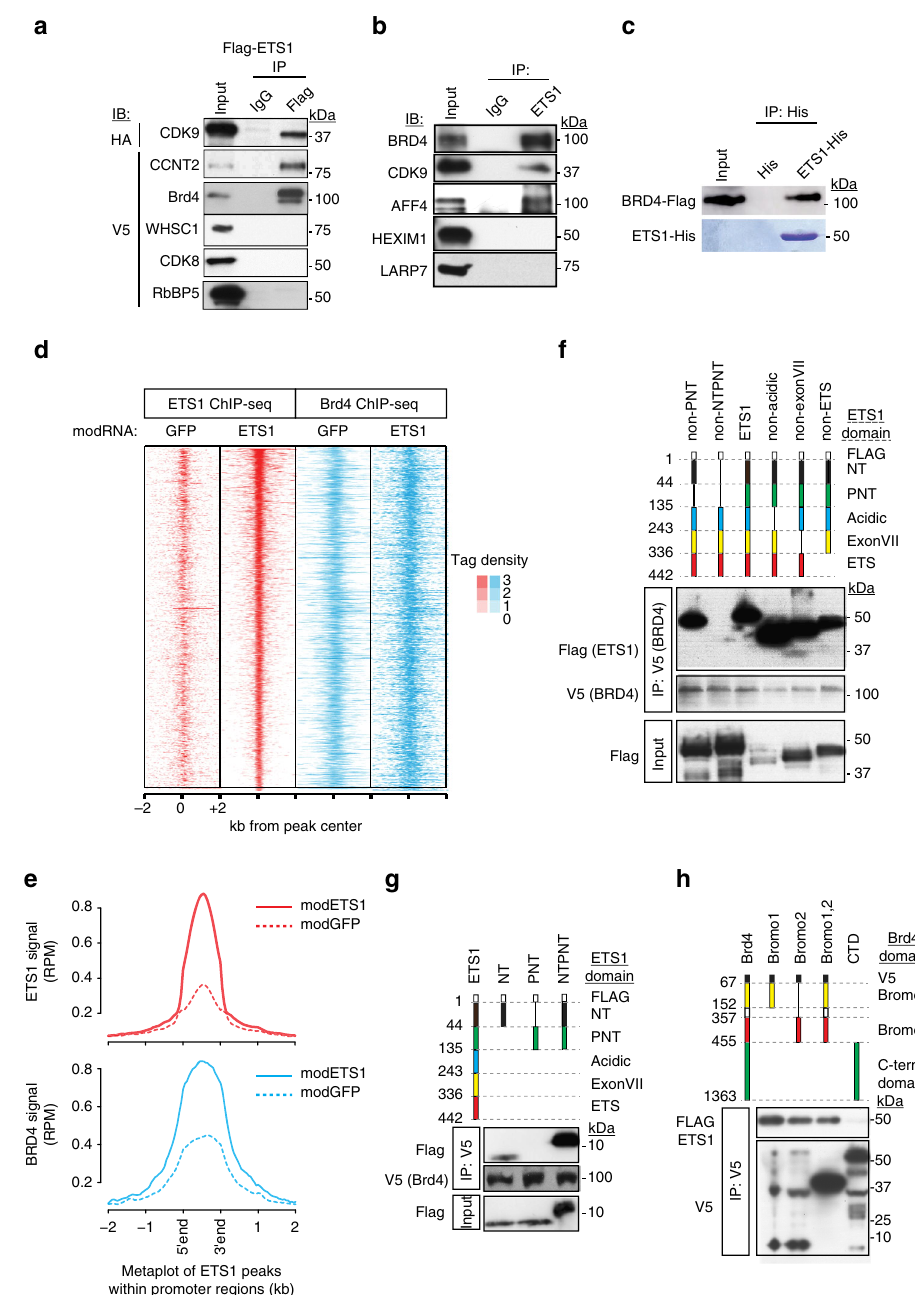
Fig. 3 ETS1 recruited P-TEFb to chromatin by direct interaction with BRD4. a ETS1 co-precipitated P-TEFb and BRD4. 293T cells were co-transfected with indicated expression constructs. ETS1 was immunoprecipitated (FLAG), and interacting proteins were detected with HA or V5 antibodies. b ETS1 interacted with active P-TEFb in HUVEC cells. Endogenous ETS1 was immunoprecipitated, and endogenous interacting proteins were detected using speci fi c antibodies. c Bacterially expressed, af fi nity puri fi ed ETS1-His bound in vitro transcribed and translated BRD4. d ETS1 and BRD4 promoter co-occupancy. HUVEC cells were transfected with ETS1 or GFP modRNA, and ETS1 and BRD4 chromatin occupancy was measured by ChIP-seq. The tag heatmap displays ETS1 and BRD4 signals from ETS1 regions within promoters. ETS1 and BRD4 co-occupied promoters, and increased ETS1 occupancy correlated with increased BRD4 occupancy. e Aggregation plots of ETS1 and BRD4 signals shown in d . f , g BRD4 binds the ETS1 NT domain. FLAG-tagged ETS1 expression constructs containing the indicated domains were co-transfected into 293T cells with V5-tagged BRD4. ETS1 deletion mutants were detected in BRD4 (V5) immunoprecipitates by FLAG immunoblotting. The NT domain was required for BRD4 binding. h BRD4 Bromo domains bind ETS1. V5-tagged expression constructs containing the indicated BRD4 domains were co-transfected into 293T cells with FLAG-tagged ETS1. BRD4 (V5) immunoprecipitates were probed for interacting ETS1 protein by FLAG immunoblotting. Either bromodomain of BRD4 was suf fi cient for ETS1